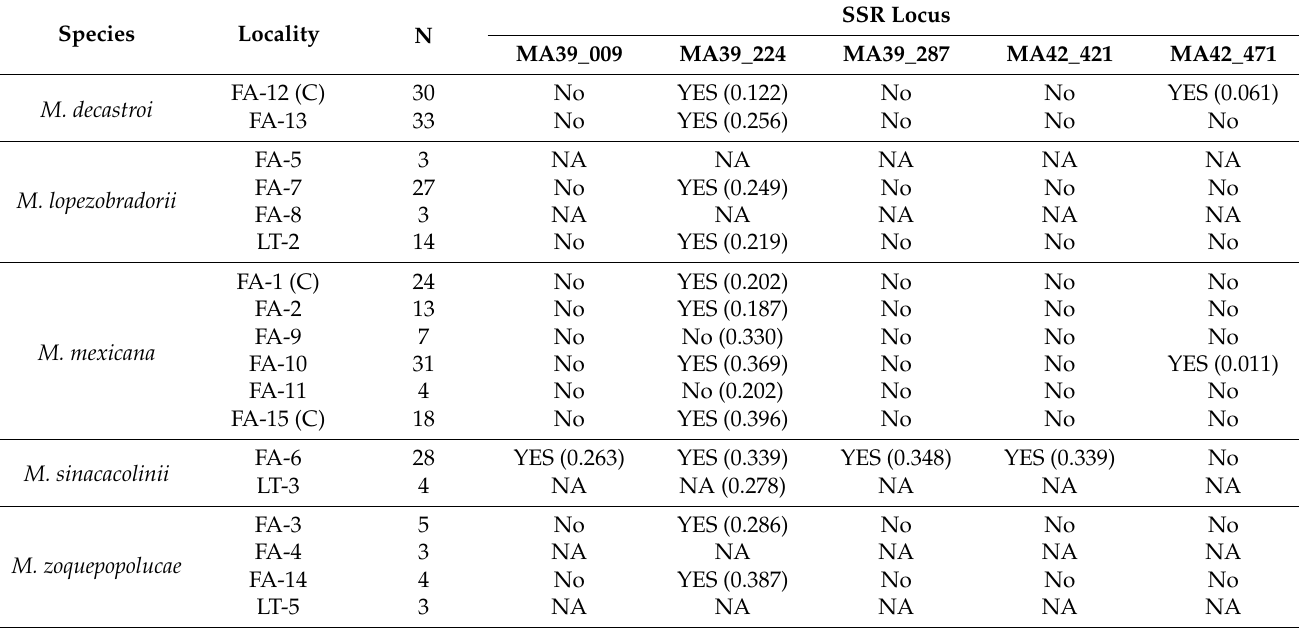
Table 1. Results of MICRO-CHECKER and ML-NullFreq analyses for null alleles on the Single Sequence Repeat (SSR) dataset of five Magnolia species in Puebla and Veracruz, Mexico. Only SSR loci for which potential null alleles were detected by MICROCHECKER are tabulated. N: sample size. NA: not available due to small sample size. Where a potential null allele was found the frequency as calculated by ML-NullFreq is given between brackets. Metadata for the locality abbreviations can be found in Table 5. Metadata of the SSR markers are specified in [42]. (C) marks cultivated sample localities as opposed to the wild sample